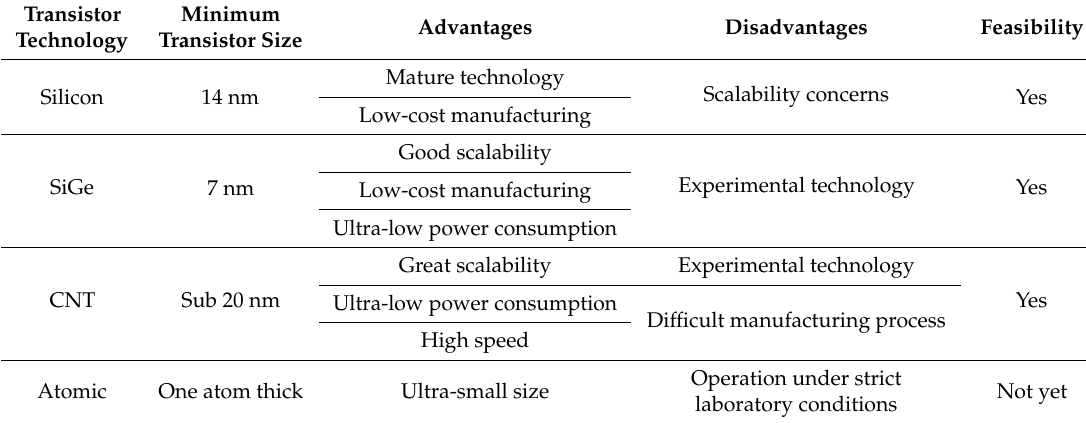
Table 1. Comparison of nanoprocessor